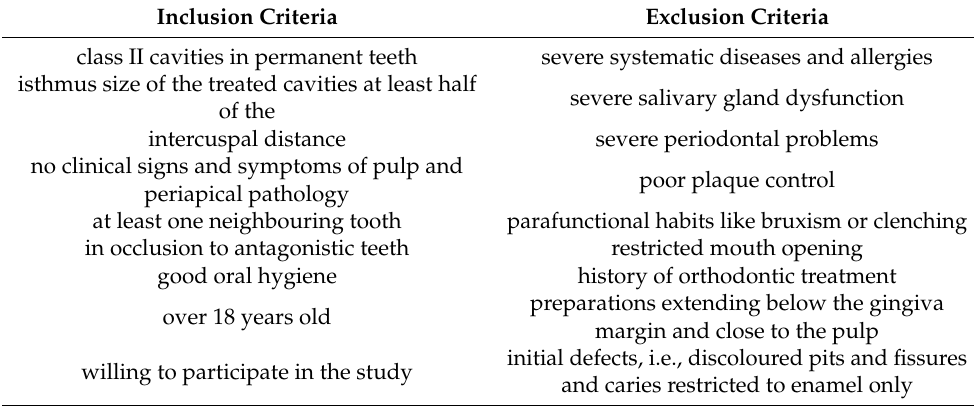
Table 1. Inclusion and exclusion criteria of patients.